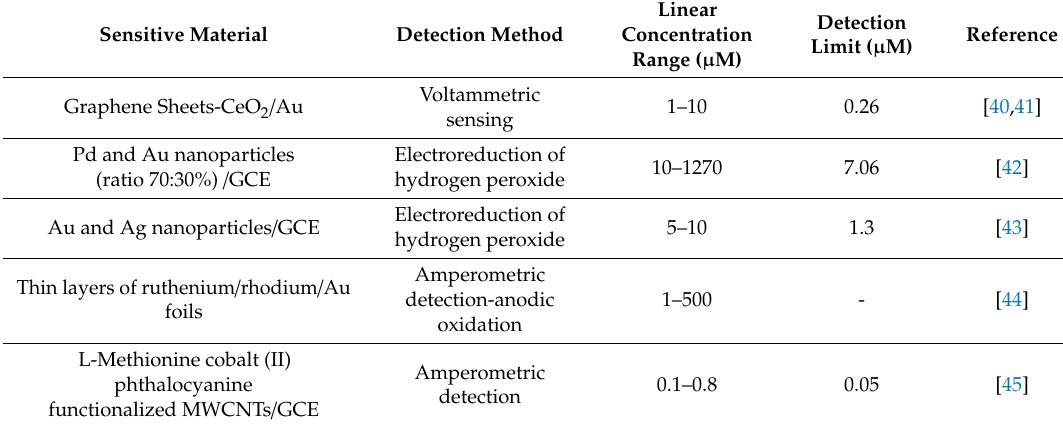
Table 1. Linear concentration ranges and detection limits of recently developed electrochemical and optical sensors for the determination of hydrogen peroxide, using di ff erent sensitive